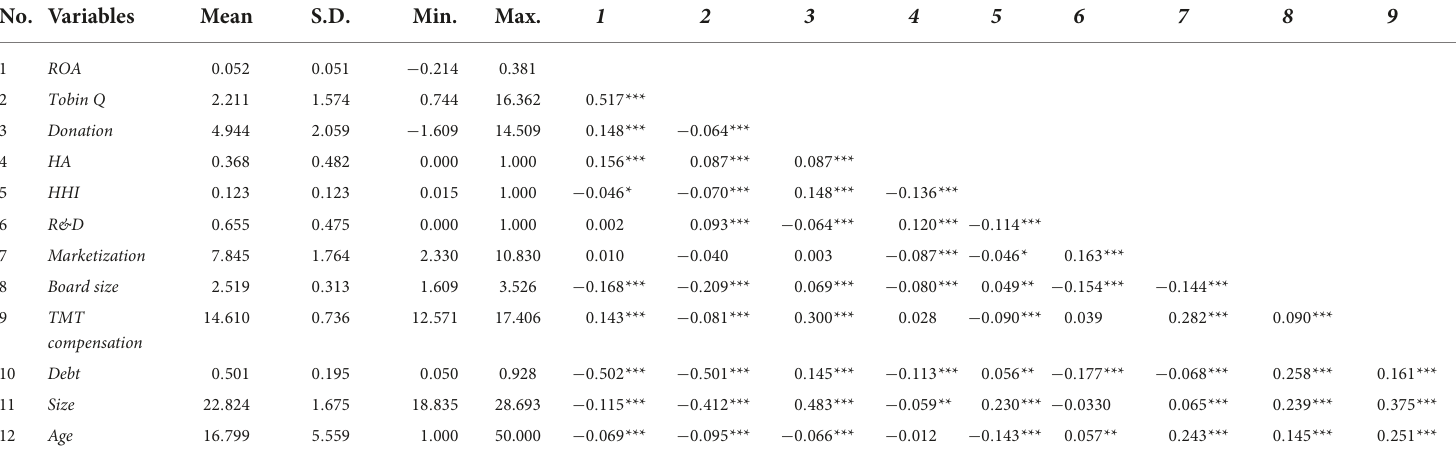
TABLE 4 Descriptive statistics and correlation matrix of Heckman’s second-stage